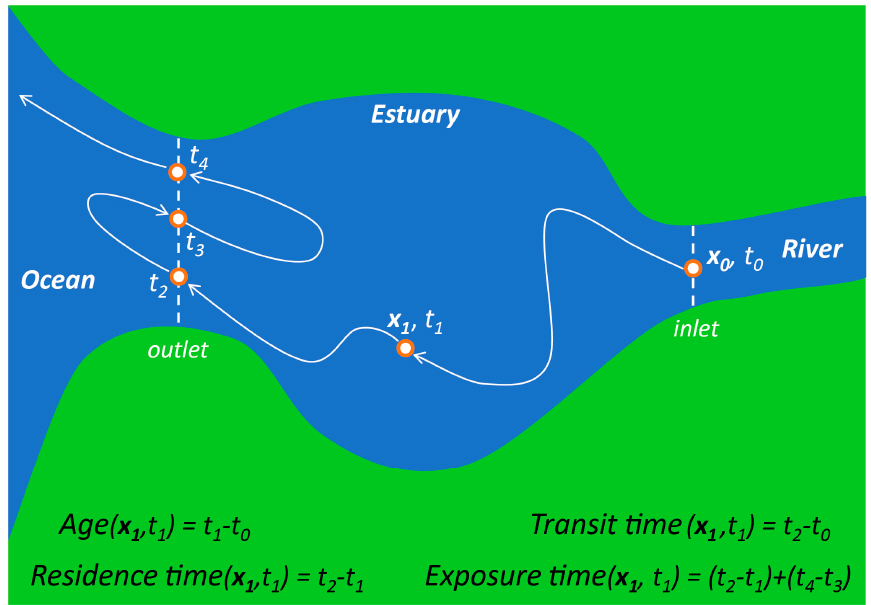
Figure 3. Schematic depicting the relationships between space- and time-dependent age, (strict) residence time, transit time, and exposure time, following Zimmerman [96], Delhez [98], Shen and Haas [121], Viero and Defina [130], Andutta et al. [22], and others. The dots represent successive locations for a single particle following a trajectory passing through locations x i at times t i . x 0 and t 0 are the initial location and time.